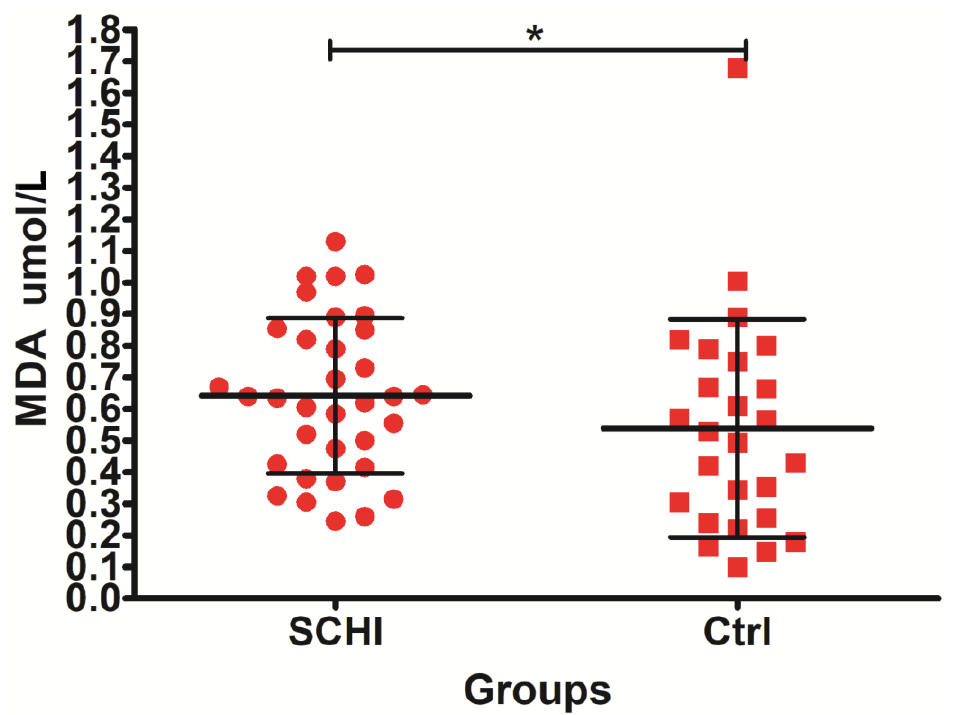
Figure 2. The level of malondialdehyde (MDA) concentration in the plasma of patients with schizophrenia compared to the control group. * indicates p -value < 0.05.